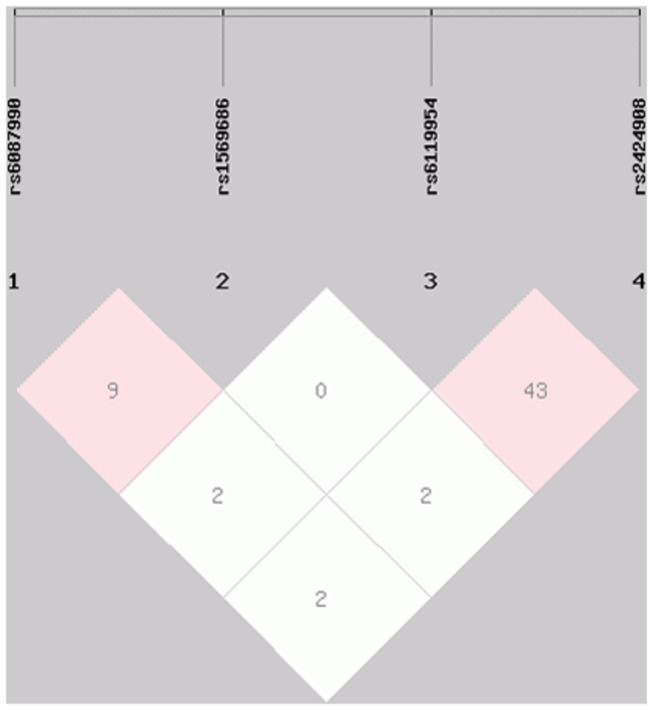
Linkage disequilibrium structure of the selected 4 SNPs on DNMT3B gene (rs6087990, rs1569686, rs6119954 and rs2424908) Values were showed in r2.